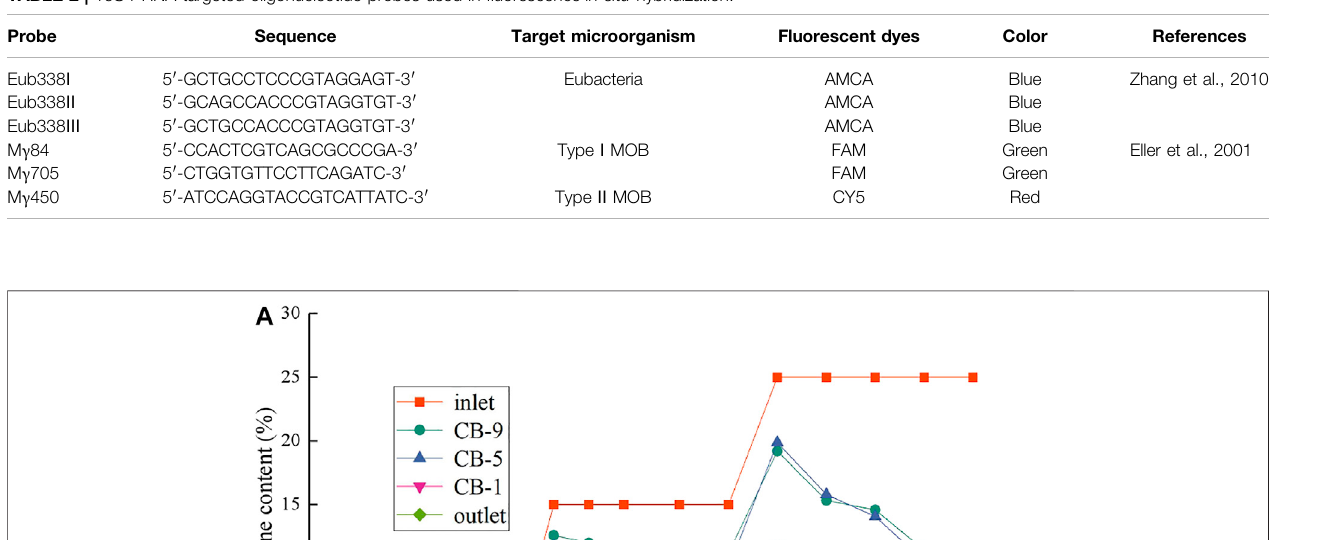
Frontiers in Bioengineering and Biotechnology |